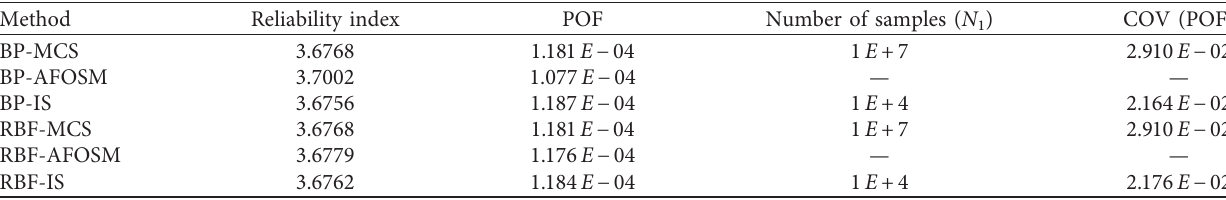
Table 9: Comparison of the reliability index and POF from different reliability analysis methods with an ANN sample size of 100. Method